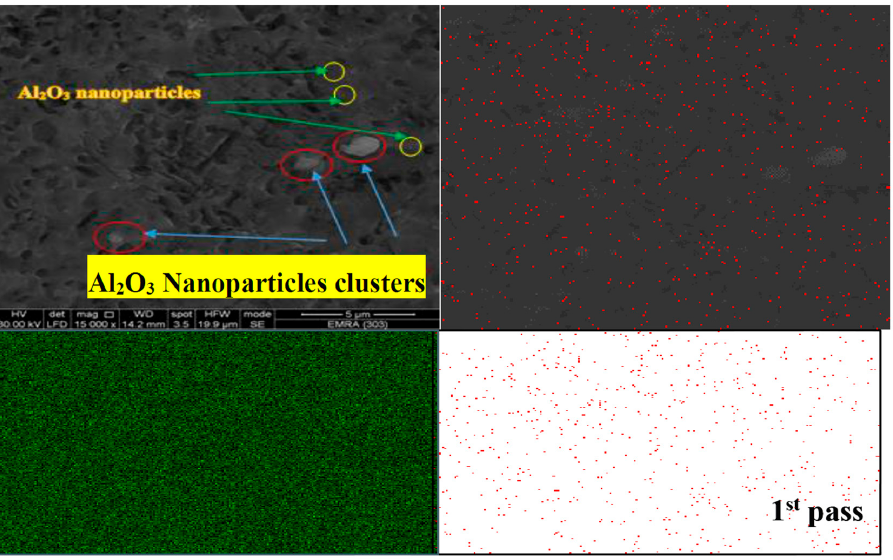
Figure 13. Elemental map of MMNCs and energy-dispersive X-ray spectroscopy (EDS) analysis in FSP at first pass at 1120 rpm at 10 mm/min.